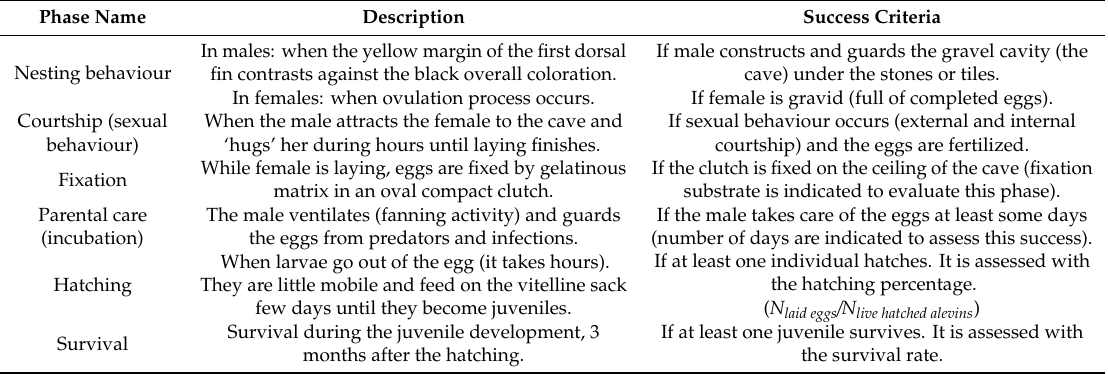
Table 1. Description of each phase and the success criteria used. The male naturally guards the eggs until the hatching (ca. 30 days), but most times it happens that the clutch is removed from the breeding tank to be put it in the rearing